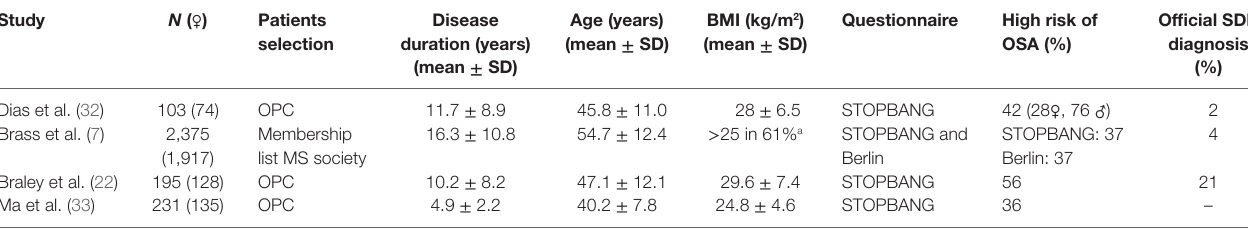
TaBle 2 | Screening questionnaires for OSA in people with multiple